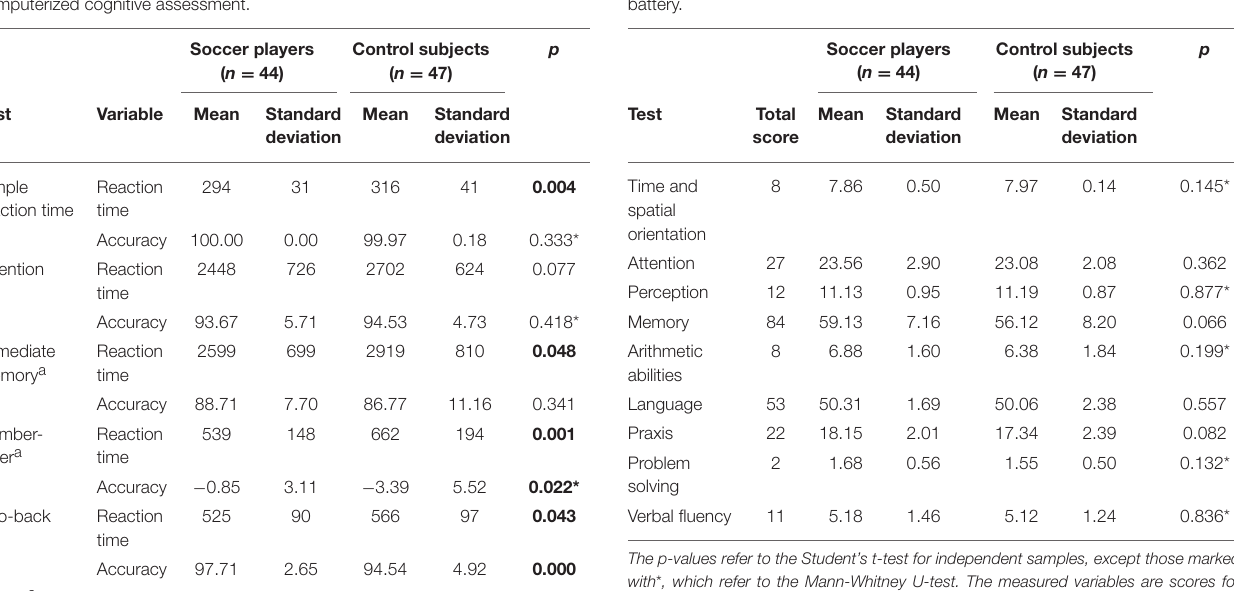
TABLE 2 | Comparison between soccer players and control subjects on Neupsilin battery.